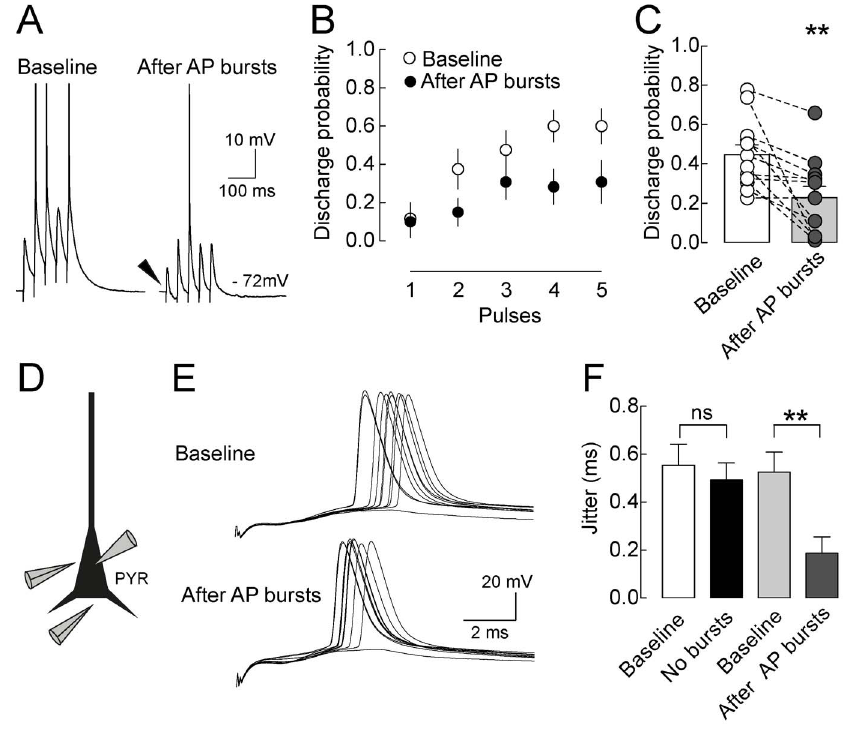
Figure 10. Long-term plasticity of GABAergic synapses strongly affects pyramidal neuron spike output. (A) Representative voltage recordings of a layer 5 pyramidal neuron showing PSP summation and occasional AP firing in response to a presynaptic train of 5 pulses at 25 Hz before (left trace) and after LTPi induction (right trace). Note the change in the first PSP waveform (arrowhead) and the reduced ability of firing after LTPi. APs were truncated for illustration purposes. (B) Graph illustrating average pyramidal neuron discharge probability before (open circles) and 15 min after LTPi (solid circles) for each synaptic stimulus within the train. (C) Population graph illustrating the total discharge probability across the entire train. (D) Schematic drawing of the recording and stimulating configuration: a layer 5 pyramidal neuron is recorded, while PSCs are simultaneously evoked by two stimulating electrodes placed near the perisomatic region. (E) Representative voltage traces showing AP firing in response to synaptic afferent stimulation before (Top) and after (Bottom) inducing LTPi by intracellularly evoked AP bursts. Note that after LTPi induction, APs occur with higher temporal precision. (F) Population data of AP jitter calculated at two time points (10 and 30 min) in the absence (white and black columns) and presence (light and dark grey columns) of LTPi-inducing bursts. Note that a significant reduction of spike jitter (i.e., increased temporal precision) occurs only after LTPi induction. Data are single mean 6 SEM. ** p , 0.001.